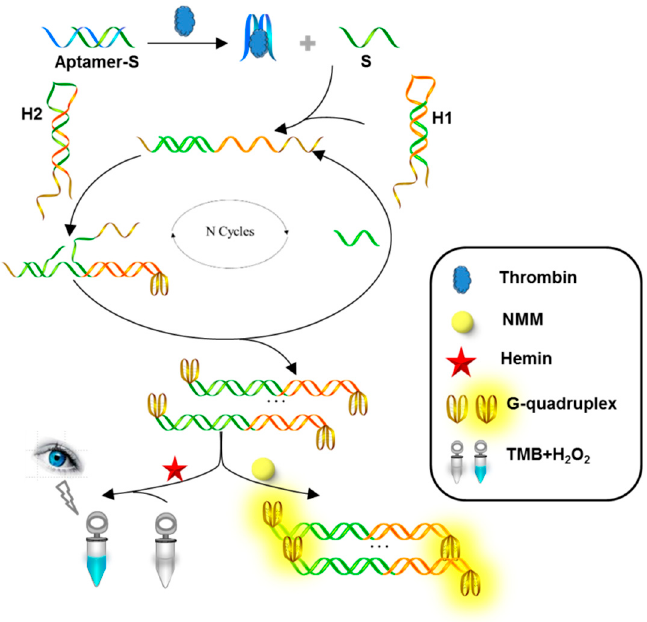
Figure 1. Schematic diagram of detecting platform based on hairpin assembly and special G-quadruplex structure.